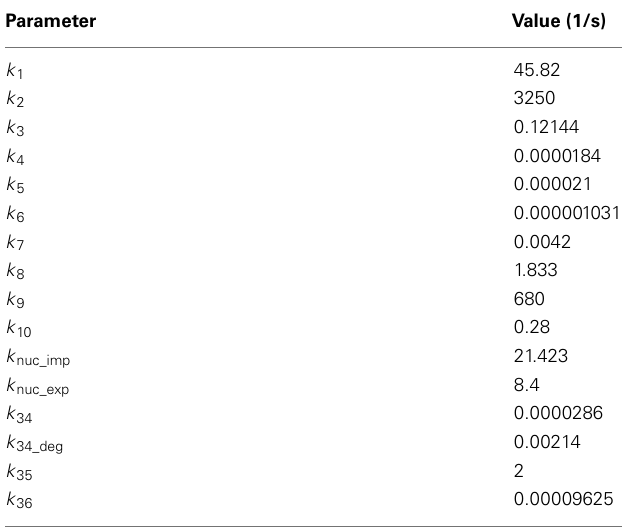
Table 3 | Parameters for the CAIN